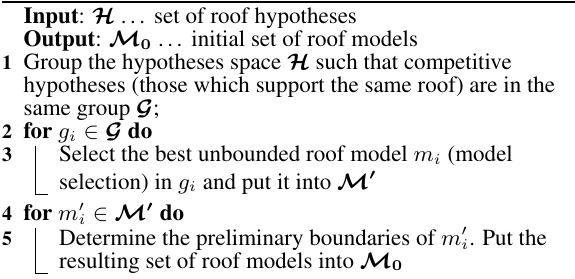
for the sake of simplicity.